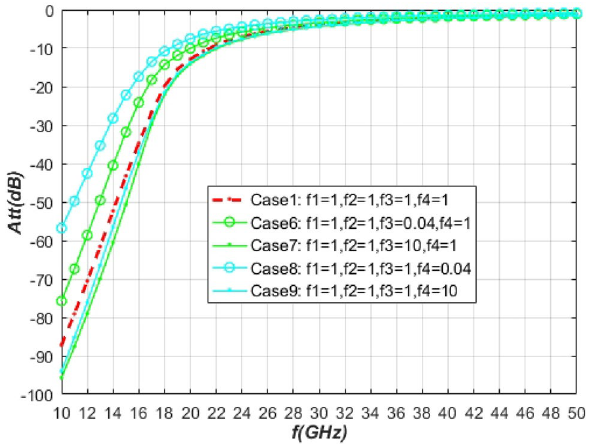
Figure 8. Attenuation of electromagnetic waves near the antenna under different ionization and non-ionization reaction